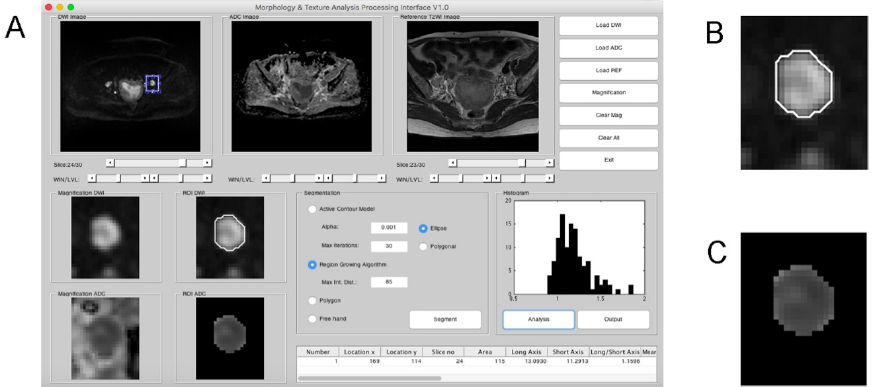
Figure 2. Computer-assisted segmentation of the lymph node (LN) based on diffusion-weighted (DW) imaging. ( A ) The graphical user interface using region growing algorithm for segmentation of LN. The apparent diffusion coefficient (ADC) values of the lymph node are used for histogram analysis. Short and long axes of the segmented lymph node were calculated automatically. ( B ) The region-growing algorithm correctly segmented the LN on DW imaging. ( C ) The segmented ADC map based on the result of (B).